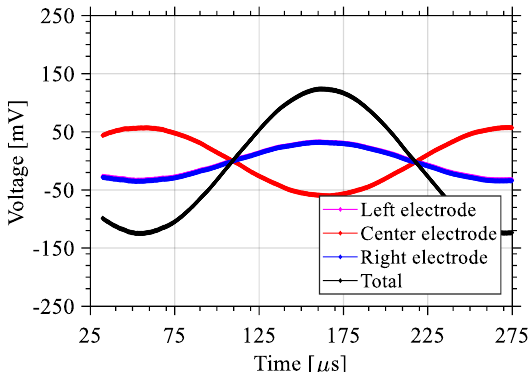
Figure 15. Output voltage of Design 1 in response to harmonic excitation at each electrode, along with the total combined output.